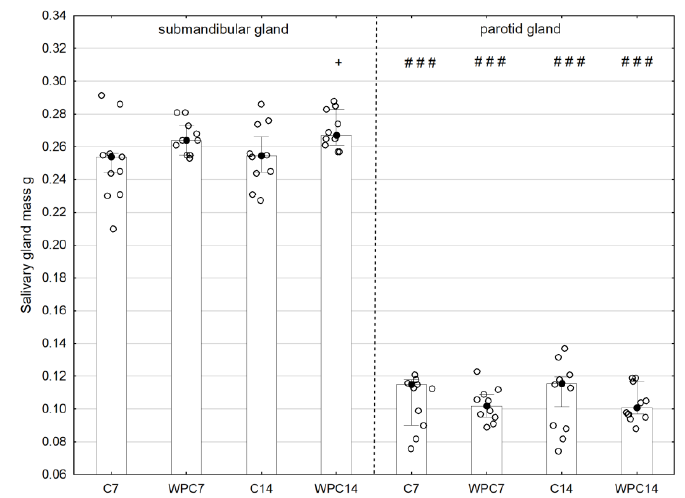
Figure 1. Salivary gland mass of rats from control and experimental groups. Abbreviations: C7, C14, control groups; WPC7, WPC14, experimental groups treated WPC-80. Data are presented as a bar chart with the individual data points; + p < 0.05 of the C14 submandibular gland and ### p < 0.001 of the submandibular gland, respectively, for the same groups. Because the results were not normally distributed, the Mann–Whitney test was used to compare differences between the studied groups. Exposure to WPC-80 for 7 and 14 days resulted in a statistically lower total protein content in the parotid glands in comparison with the corresponding controls ( p < 0.001) and in comparison to the submandibular glands ( p < 0.001) (Figure 2).